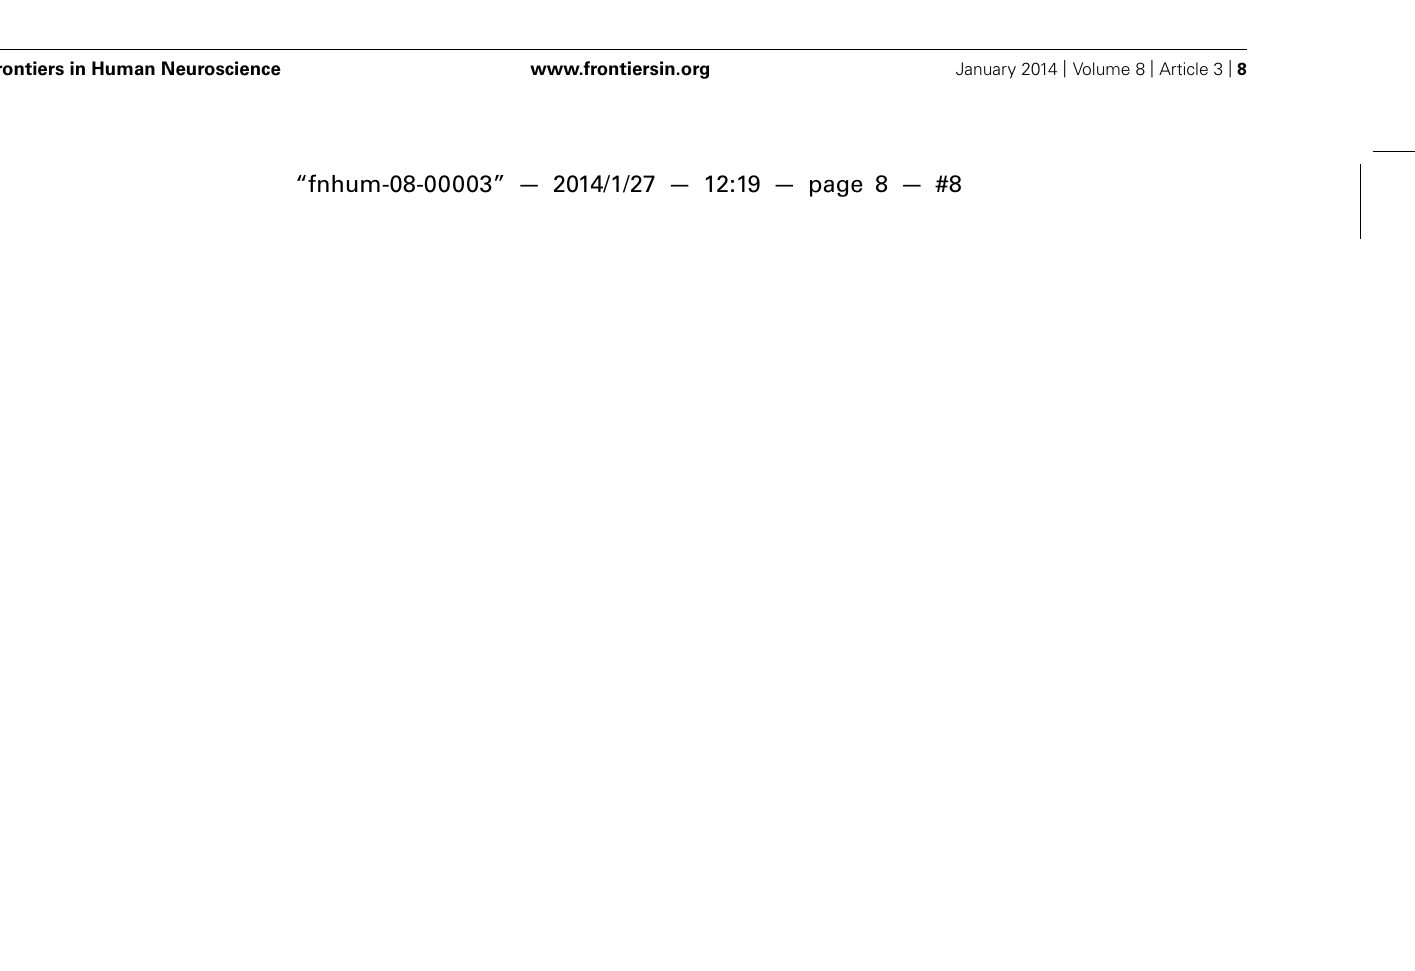
FIGURE 3 | (A) Mean overestimation (and SD, in cm) of perceived peripersonal space for HC, LH, and RH for judgments provided according to the right or the left hand. (B) Individual overestimation (in cm) of perceived peripersonal obtained with the hemiplegic and healthy hand for LH and RH. Mean performances obtained with the right and